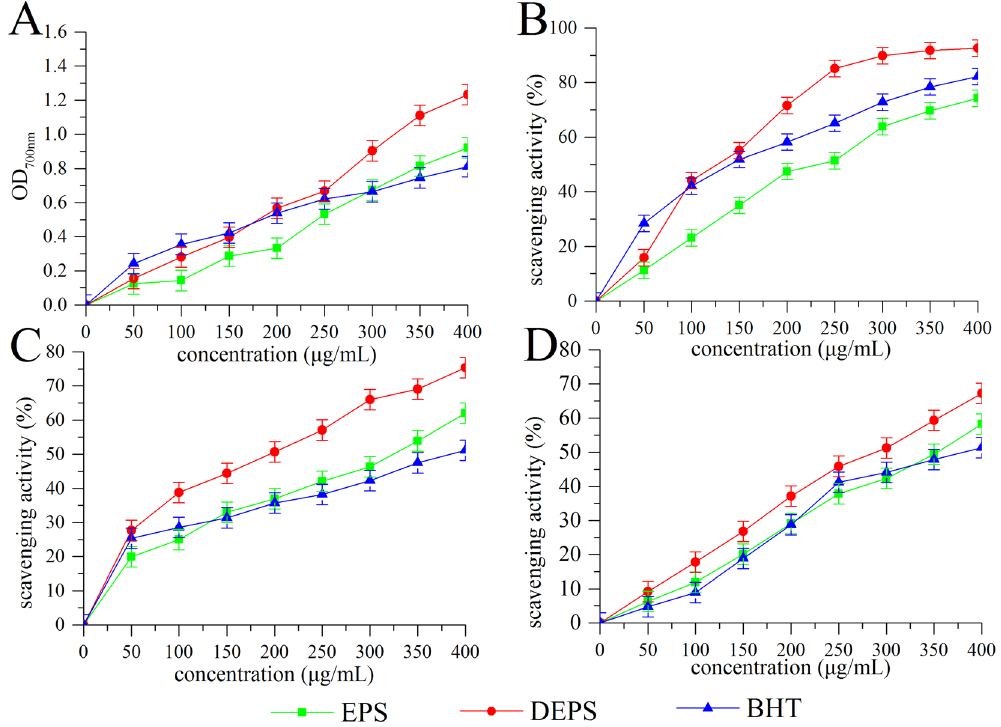
Figure 1. Antioxidant activities of EPS and DEPS in vitro . Reducing power ( A ) and scavenging activities towards DPPH radicals ( B ), hydroxyl radicals ( C ), and superoxide anion radicals ( D